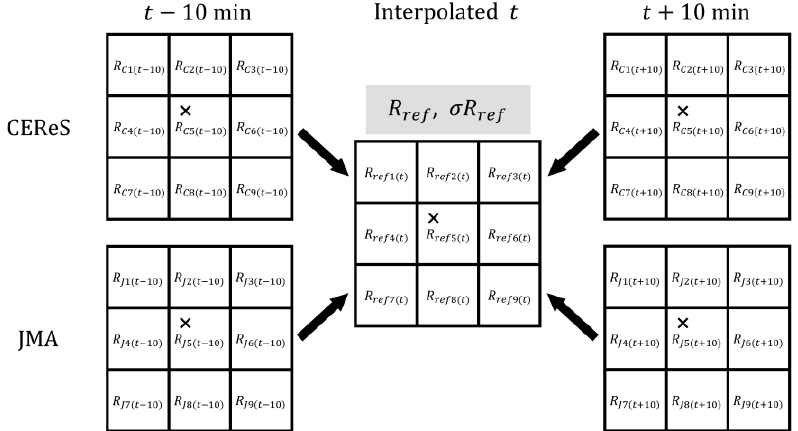
Figure 3. Schematic showing the calculation of reference pixel values at an observation time ( t ). The average ( R ref ) and standard deviation ( σ R ref ) were calculated using interpolated 3 × 3-pixel values centered at the site (“x”); these were calculated using the mean of pixel values at t-10 min and t + 10 min in both the CEReS and JMA data. These data were used for stability evaluation.